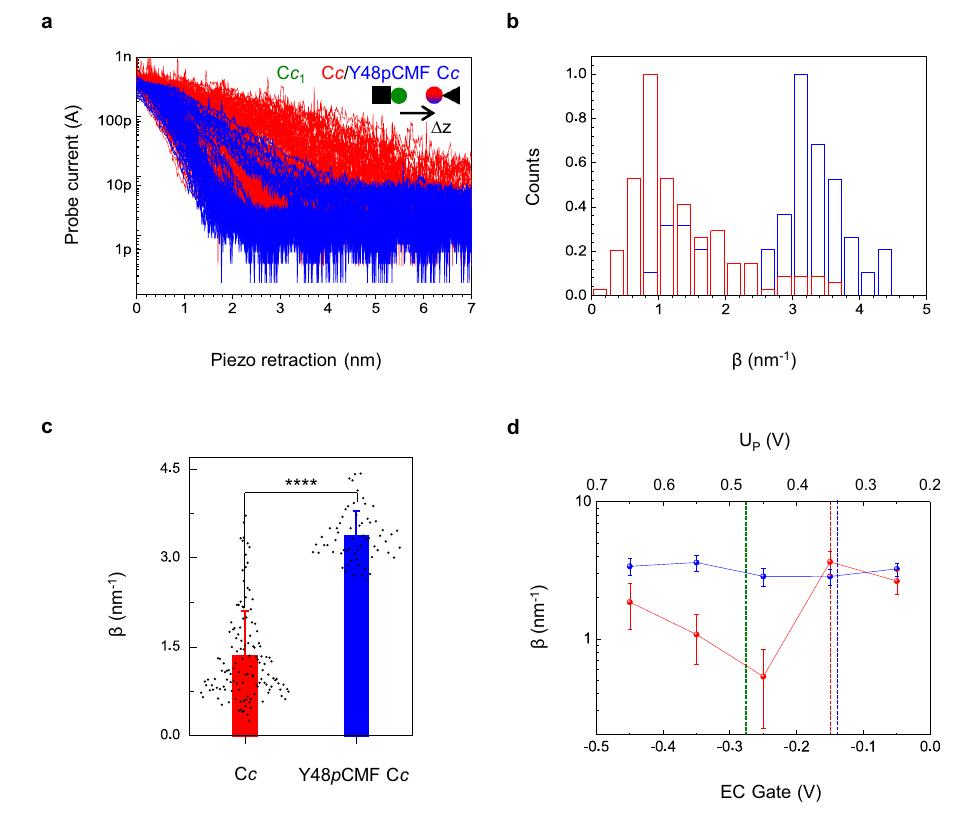
Fig. 1 | Current-distance electrochemical tunneling spectroscopy of C c 1 -C c . values(mean±s.d.of n =80)vs.ECgatepotentialat200mVconstantbiasobtained a Ensemble of semi-logarithmic current-distance ( I-z ) curves during probe retrac- forC c 1 -C c (red)and C c 1 -Y48 p CMFC c (blue).The midpoint redoxpotentials for C c 1 at the sample (0.276V; green dashed line) and C c or Y48 p CMF C c (red and blue tion,showingamoreabruptcurrentdecayforC c 1 -Y48 p CMFC c .Sampleandprobe electrodes are represented by a square and a triangle, respectively. Us= − 200 mV dashed lines, respectively) at the probe are indicated, showing the β minimum for vs. SSC and atconstant bias of 800mV. b Histograms ofdistancedecay factors( β ) C c 1 -C c is lo c atedwithin the midpoint redoxpotentials of C c 1 and C c . Despite being quanti fi ed from individualcurves in a . c plot of the averaged β values (mean±s.d.) redox-activeatsimilarpotentialthanC c ,Y48 p CMFC c didnotdisplaya β minimum β =1.3±0.8nm − 1 for C c within the measurement range. All experiments were performed in 50mM phos- 1 -C c (n=103 I-z curves from 2 independent experiments, red) and β =3.1±0.4nm − 1 C c 1 -Y48 p CMF C c ( n =64 I-z curves from 2 independent phate buffer, pH 6.5. Initial current set point 0.4nA. Averaged β values for C c 1 -C c experiments, blue), respectively, showing signi fi cant differences (two-sample t- (red) are reproduced from reference 4 4 . Source data are provided as a Source Data fi test, t Statistic = 19.65, degrees of freedom = 195, **** P <0.0001). d Averaged β